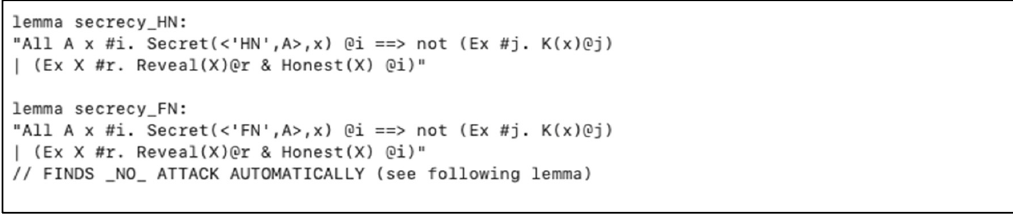
Figure 10. Session hijacking and perfect forward secrecy resistance lemmas in HN and FN .